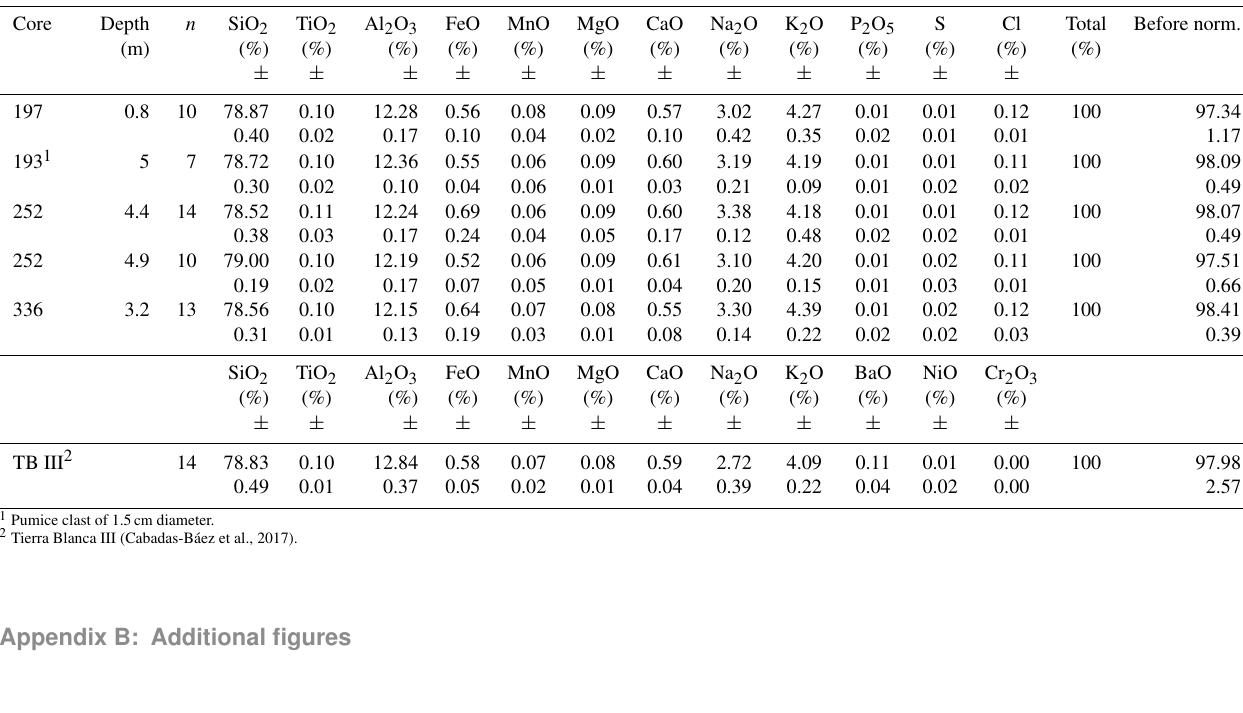
Table A3. Major-element composition (mean and SD) of volcanic glass and pumice fragments recovered from the beach-ridge sediments along Transect A. Oxide concentrations are normalised to 100% on a volatile-free basis. All iron is taken as FeO. The major-element composition of volcanic glass shards from Tierra Blanca III were generously provided by Hector V. Cabadas-Báez (Cabadas-Báez et al., 2017).